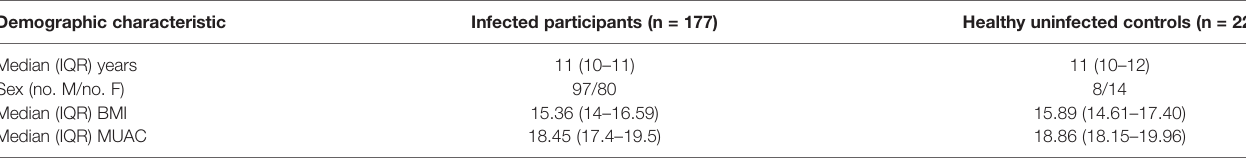
TABLE 1 | Demographic characteristics of the study participants and the status of infection. Demographic characteristic